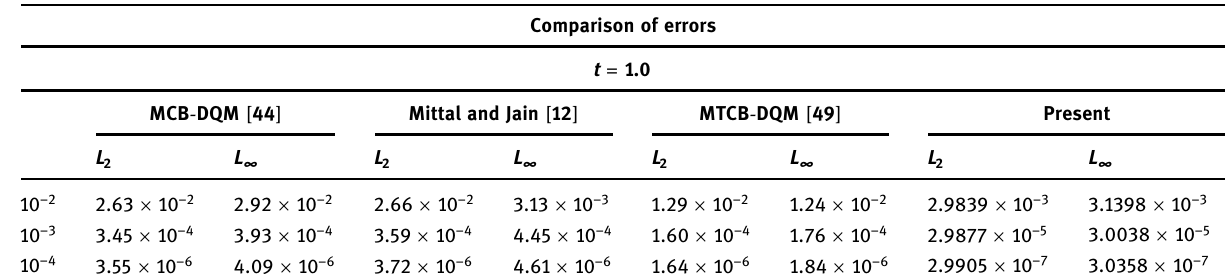
Table 4: Comparison of errors at = t